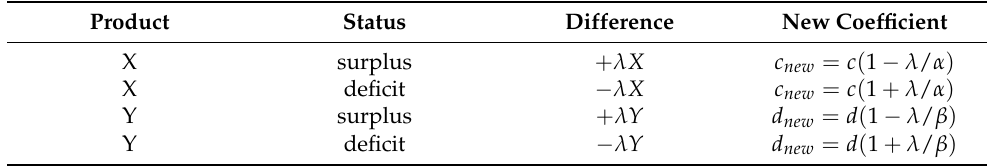
Table 5. Table of recalculated prices of X and Y in RM1 for the cases of product deficit and surplus. From the left to the right column, the table contains the product type, whether a surplus or a deficit of it is considered, the difference in quantity considered (by adding or subtracting λ X or λ Y ), and the newly calculated coefficient according to the difference in the